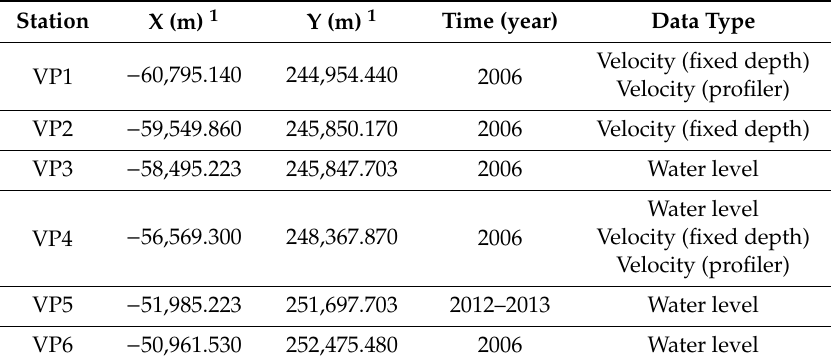
Table 1. Characteristics of the validation